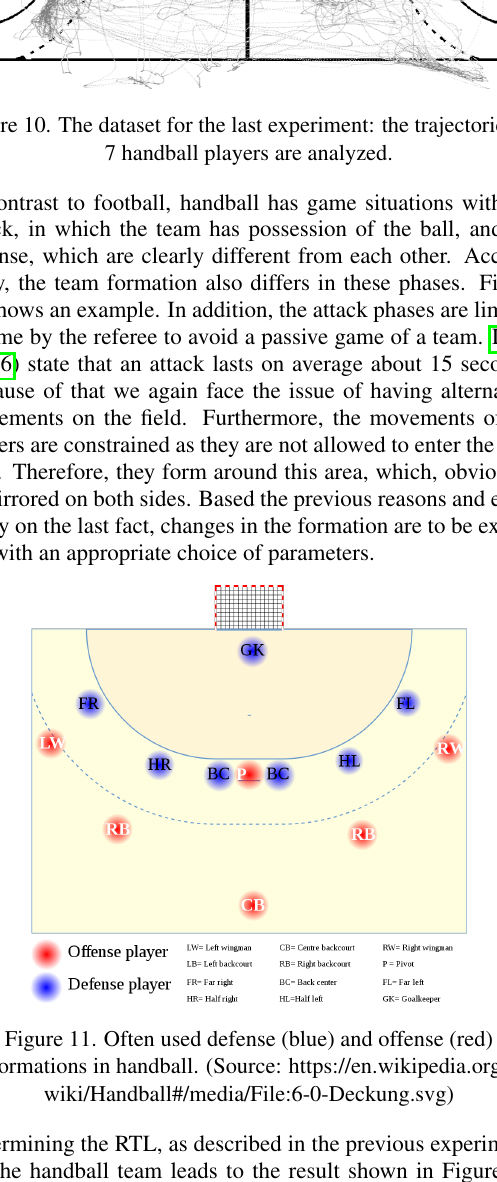
Figure 9. The identified formation changes of the observed team (except the goal keeper). The changes are visualized by arrows connecting the different player mean locations (colored dots, time annotated) during the match. The playing direction of the team is from right to left.